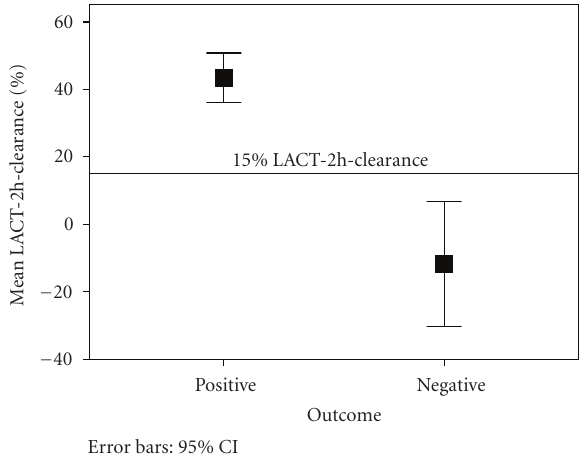
Figure 2: Mean LACT-2h-clearance for positive and negative